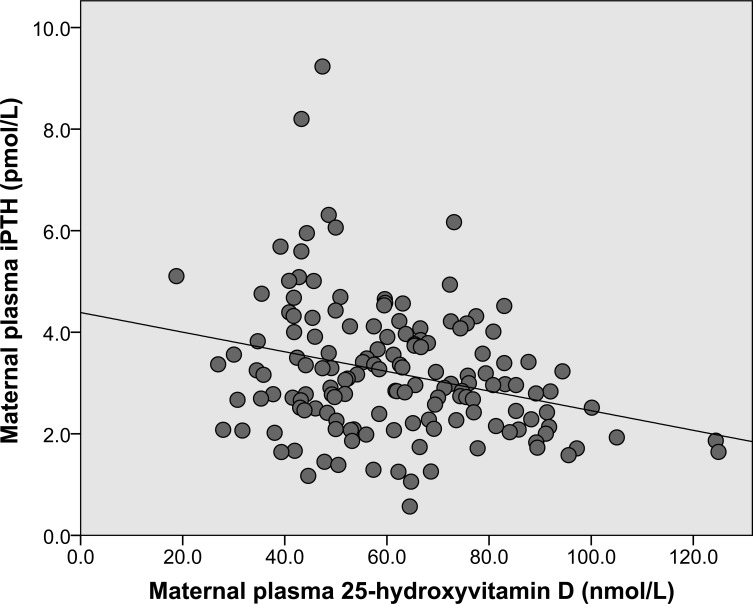
Scatter plot showing the relationship between maternal intact parathyroid hormone and 25-hydroxyvitamin D level.The maternal plasma level of 25-hydroxyvitamin D [25(OH)D]showed a weakly negative correlation with the maternal plasma level of intact parathyroid hormone (iPTH), n = 147. Linear regression equation: iPTH = –0.0193[25(OH)D] + 4.3884. (Pearson’s r = –0.29, P<0.01)